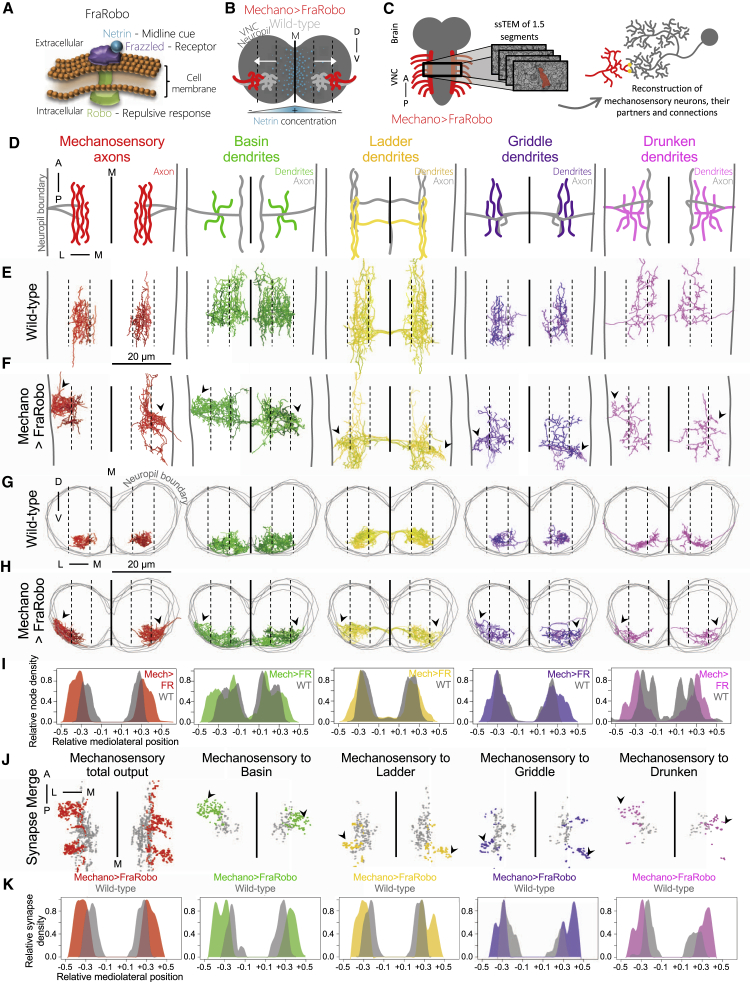
Postsynaptic Dendrites Extend Ectopic Branches to Reach Their Displaced Presynaptic Partner Axons(A) FraRobo is a chimeric receptor with the ectodomain of Frazzled and the intracellular domain of Robo (Bashaw and Goodman, 1999). FraRobo binds to Netrin, triggering a repulsive response.(B) Netrin concentration is highest at the M. Me axons expressing FraRobo (red) are more sensitive to Netrin and are repelled laterally compared with wild-type (WT) axons (light gray).(C) EM reconstruction of shifted Me axons, all their synapses and preferred local partners.(D) Schematic dorsal view of the Me axons and their preferred postsynaptic local partners in one abdominal segment. Colored regions are displayed in subsequent panels.(E–H) Dorsal (E and F) and cross section (G and H) views of the reconstructed Me axons and postsynaptic dendrites in WT (E and G) and in a sample with FraRobo-expressing Me neurons (F and H). In mechano > FraRobo (Mech > FR), the Me axons are displaced laterally (arrowheads), away from the M (solid line), reaching the edge of the neuropil. The postsynaptic partners display ectopic branches in lateral domains (arrowheads). Neuropil boundary: gray vertical lines (D–F) or gray consecutive rings (G and H). Dashed lines split the width of the neuropil evenly in six sections.(I) Node density distribution of reconstructed neurons (E–H) in the mediolateral axis in WT and Mech > FR.(J) Overlay of reconstructed Me presynaptic sites in Mech > FR (colored) and WT (gray). Shifted Me axons make synapses in ectopic locations (arrowheads).(K) Density distribution of Me synapses (shown in J).See also Data S1 and Figures S1–S4.